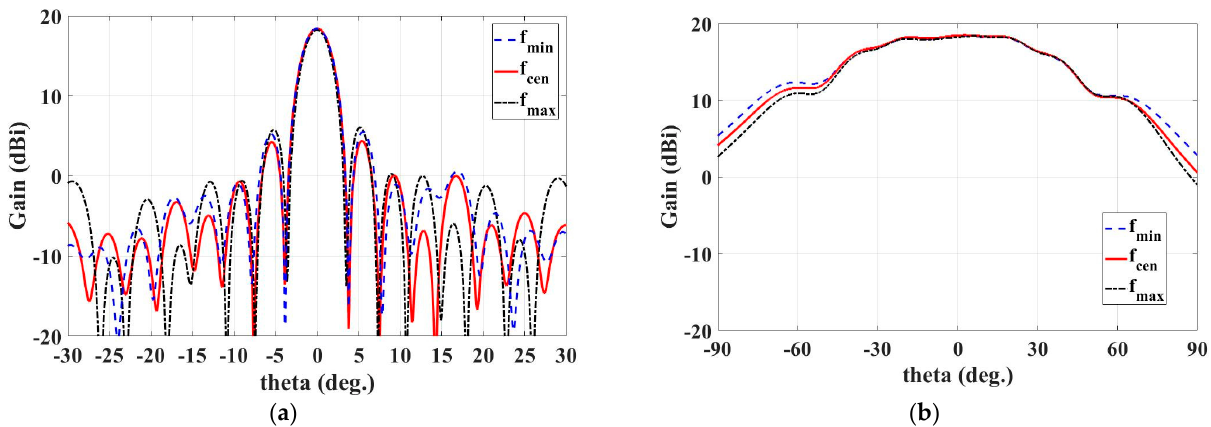
Figure 19. Subarray antenna patterns of the S-STEP SAR payload in ( a ) azimuth and ( b ) elevation.